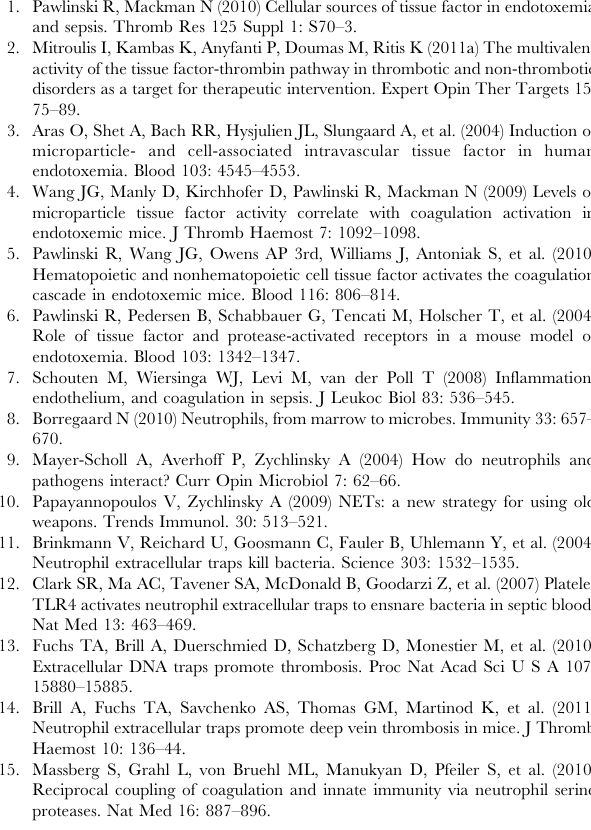
neutrophils from healthy subjects were used as control. One representative out of six independent experiments is shown (DNA labeled with DAPI; blue, anti-MPO monoclonal antibody; green) (original magnification 400 6 ). Scale bar represents 30 m M. (TIF) Figure S2 Microparticle depletion from sepsis serum. FACS analysis of sepsis serum and microparticle depleted sepsis serum by centrifugation as indicated by Annexin V-FITC staining. Isotype: sepsis serum stained with mouse IgG1-FITC. One out of three independent experiments is shown. (TIF) Figure S3 Localization of TF or MPO in LC3B-coated structures in control neutrophils treated with inflam- matory stimuli. ( A ) Single plane analysis of TF or MPO localization in LC3B-coated structures in control neutrophils treated with septic serum for 60 mins. (DNA labeled with DAPI; blue, anti-TF monoclonal antibody or anti-MPO monoclonal antibody; green, anti-LC3B mAb; red) (original magnification 1000 6 ). Arrows indicate LC3-coated autophagosomes. Scale bar represents 5 m M. ( B ) TF and LC3B localization in control neutrophils treated with inflammatory cytokines and/or E. coli at various time points. Colocalization of TF with LC3B is detected both intracellularly and in NETs only in neutrophils treated with both cytokines and E. coli . Neutrophils treated with E. coli alone do not express TF. (DNA labeled with DAPI; blue, anti-TF mAb; green, anti-LC3B mAb; red) (original magnification 1000 6 ). One out of three independent experiments is shown. Scale bar represents 5 m M. (TIF)